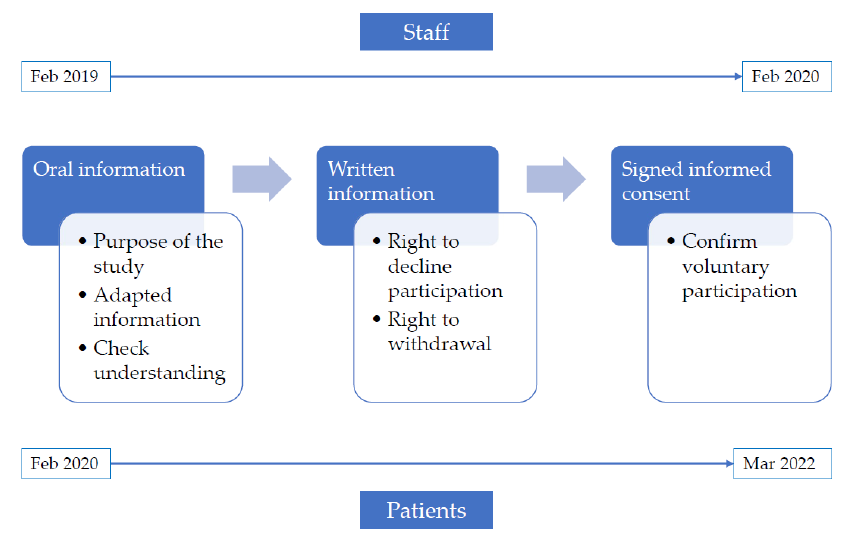
Figure 1. Data collection flow diagram.